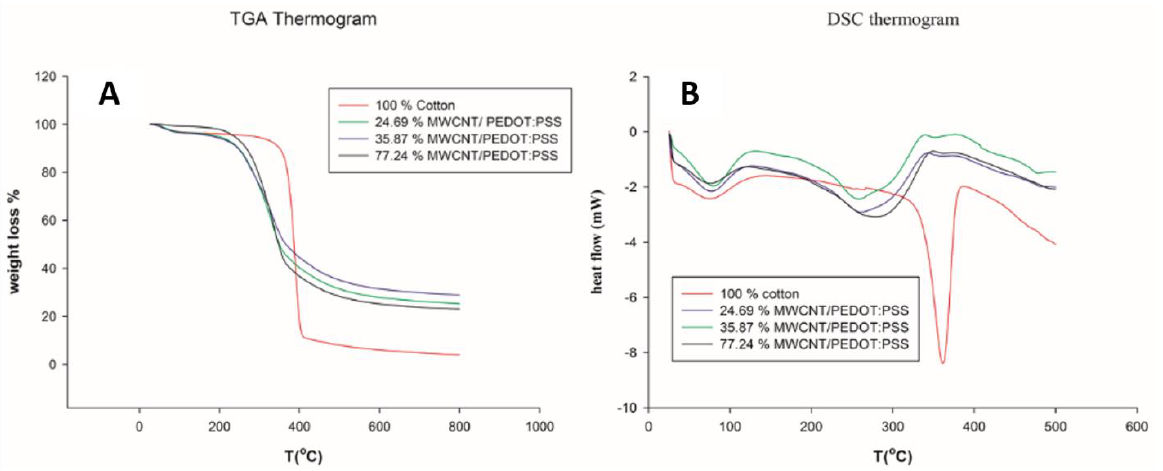
Figure 2. TGA curve ( A ) and DSC thermograms ( B ) of the cotton fabric and its nanocomposite treat- ment.